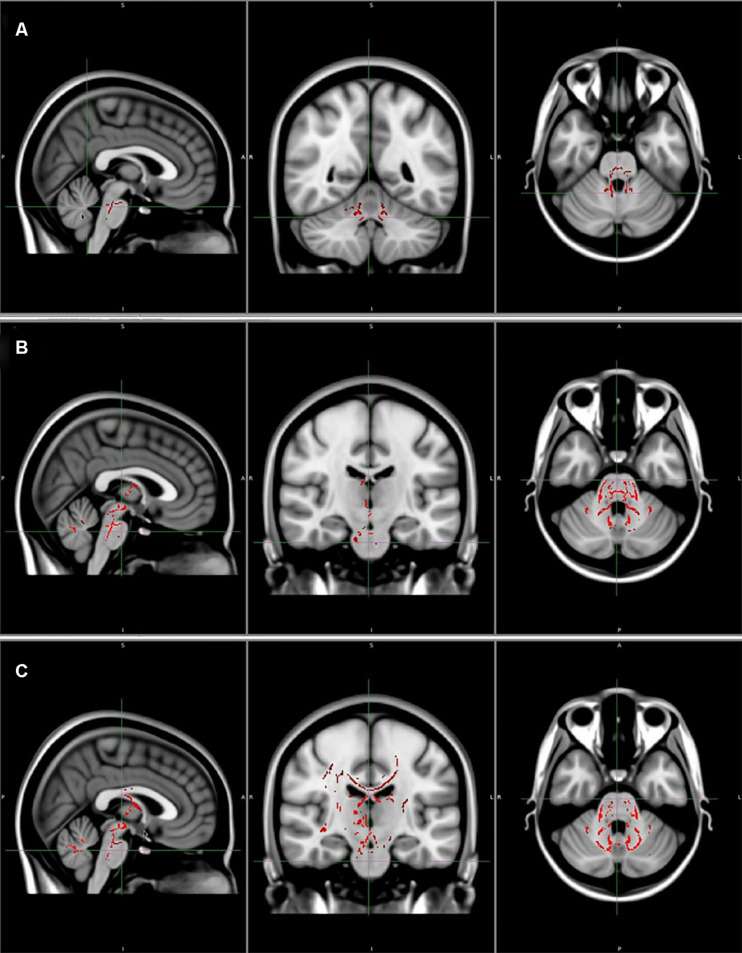
(A) Areas of reduced fractional anisotropy (P < 0.05, corrected). (B) Areas of increased axial diffusivity (P < 0.05, corrected). (C) Areas of increased radial diffusivity (P < 0.05, corrected). Reprinted with permission from Wiley (Guimarães et al., 2013).